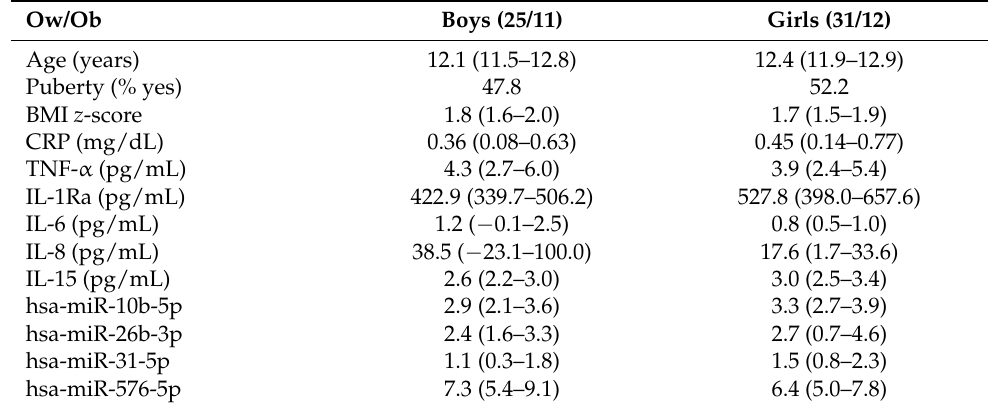
Table 1. Anthropometric and chemical characteristics of the study